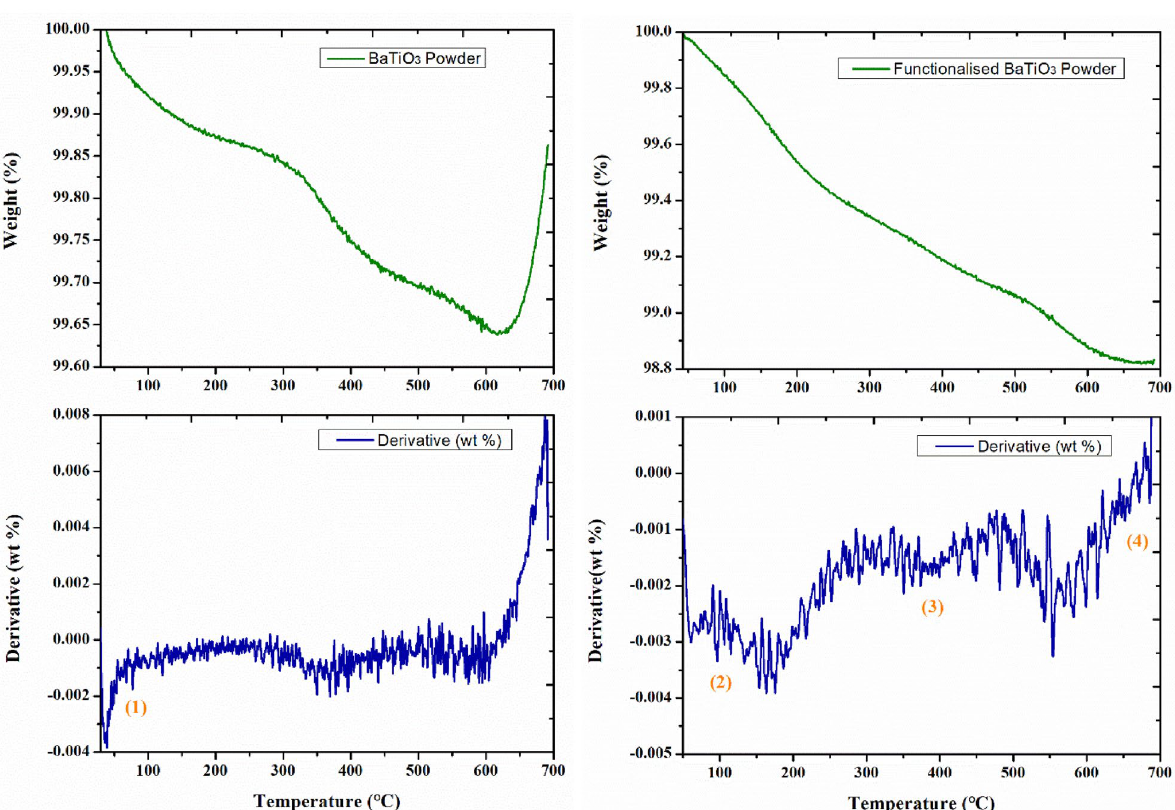
Figure 9. TGA curves of untreated and Si-BaTiO 3 powders. Green lines indicate the weight percentage of the powders versus temperature, and blue lines the rate of change of the weight percentage versus